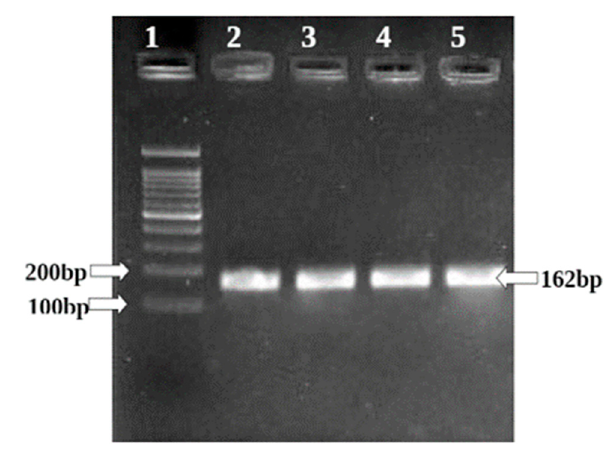
Figure 12. Amplification of GAPDH in HepG2 cell line.